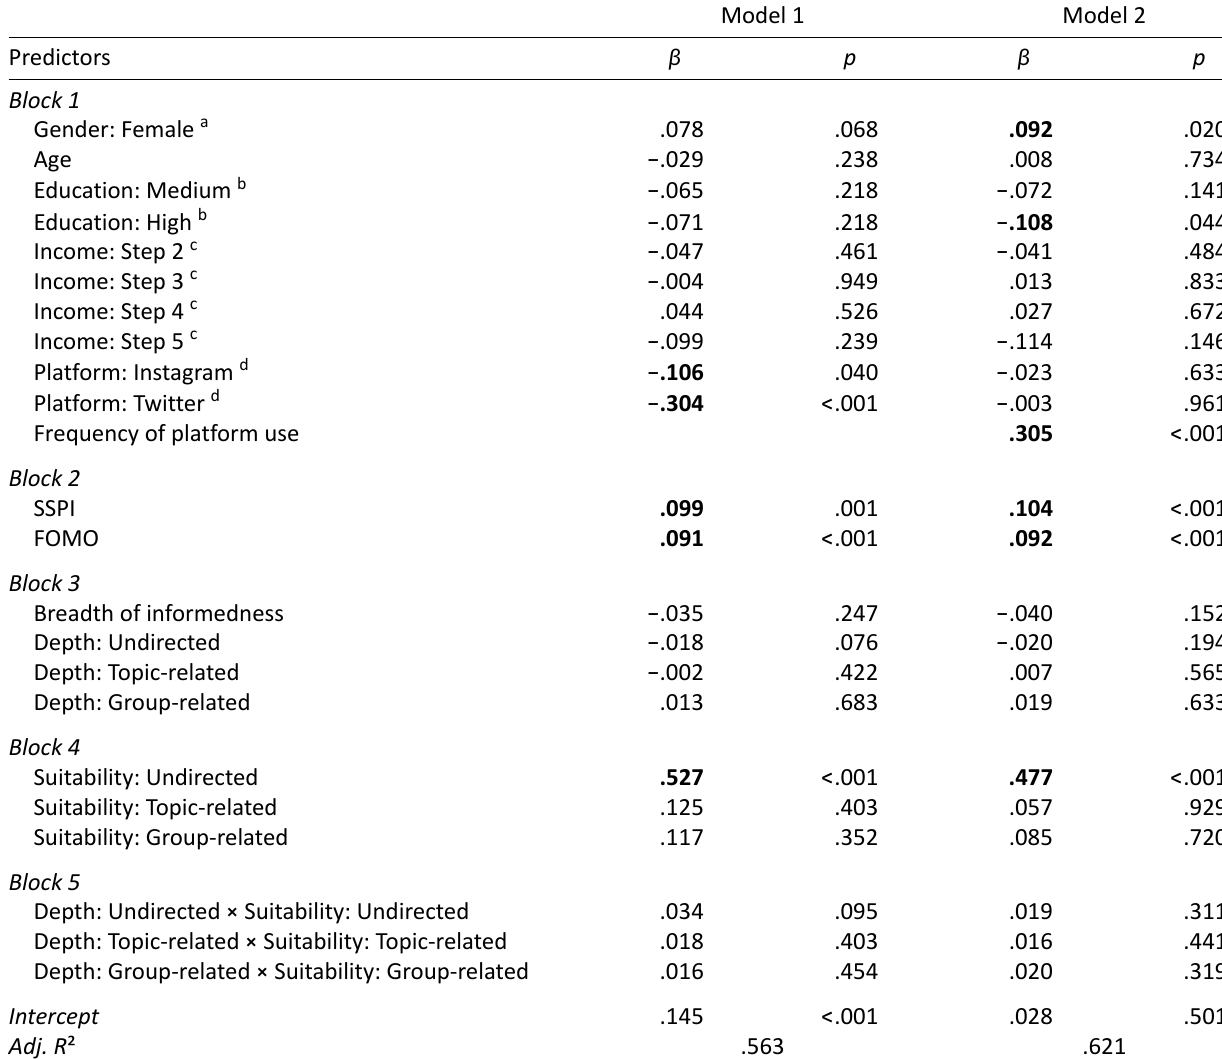
Table 2. Linear regression model predicting FOBI through a social media